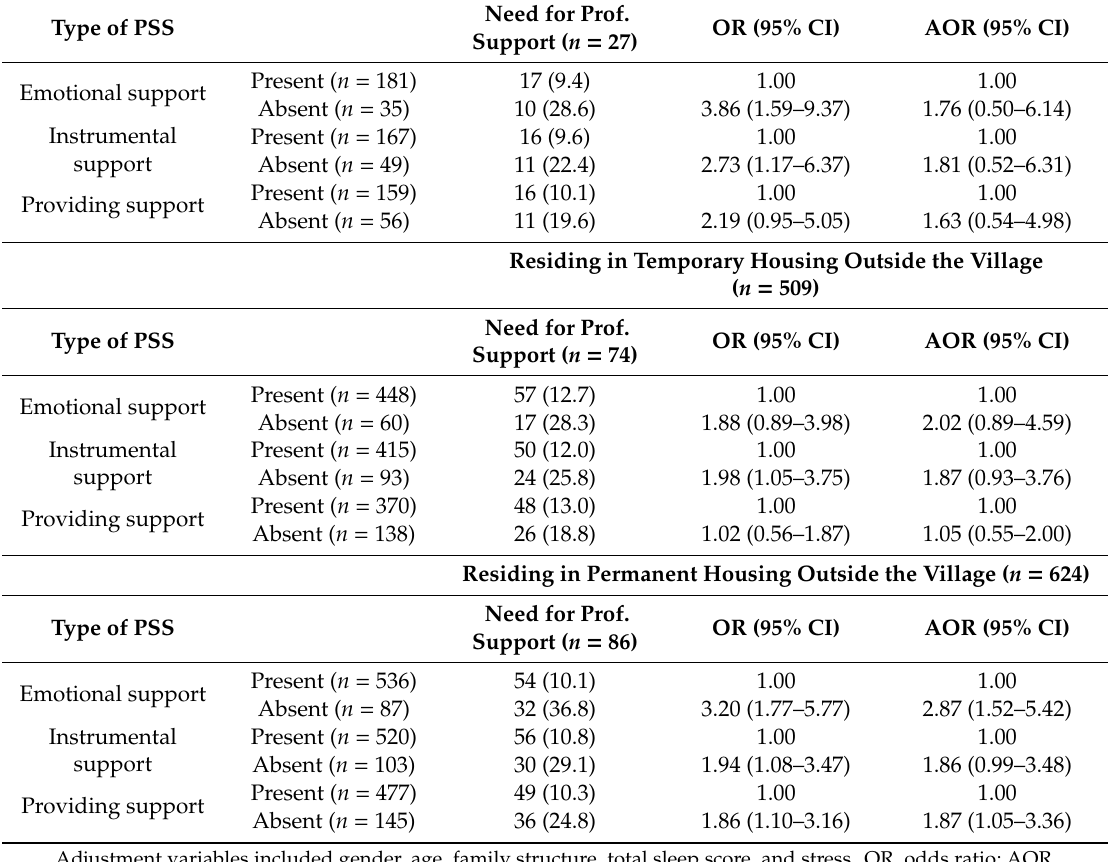
Table 2. Relationships among PSS and need for professional support in di ff erent living environments. Type of